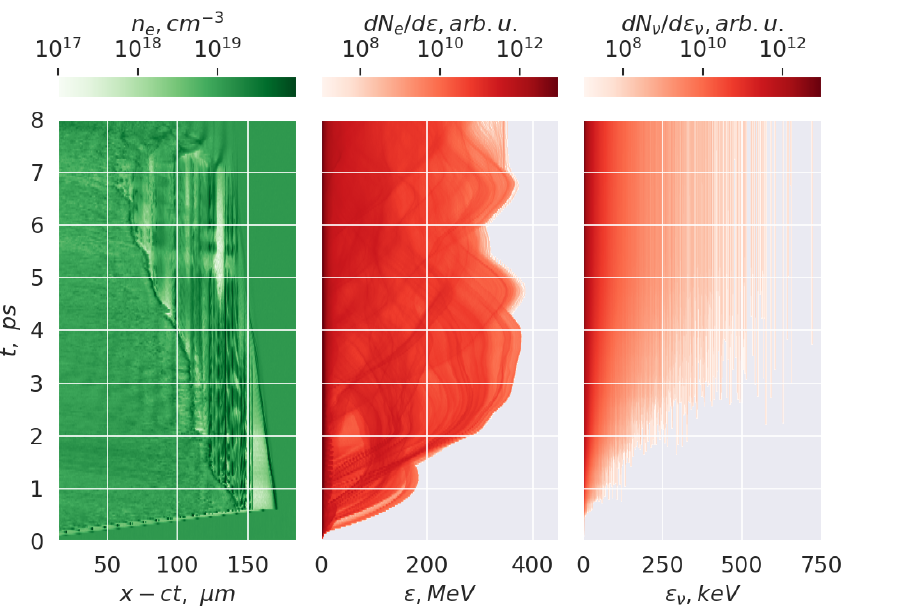
Figure 2. Simulation results for a Gaussian laser pulse with a duration of 11 fs. Spatiotemporal dynamics of electron density at y = 0 ( left ), time dependence of generated electron spectra ( center ), time dependence of generated photon spectra ( right